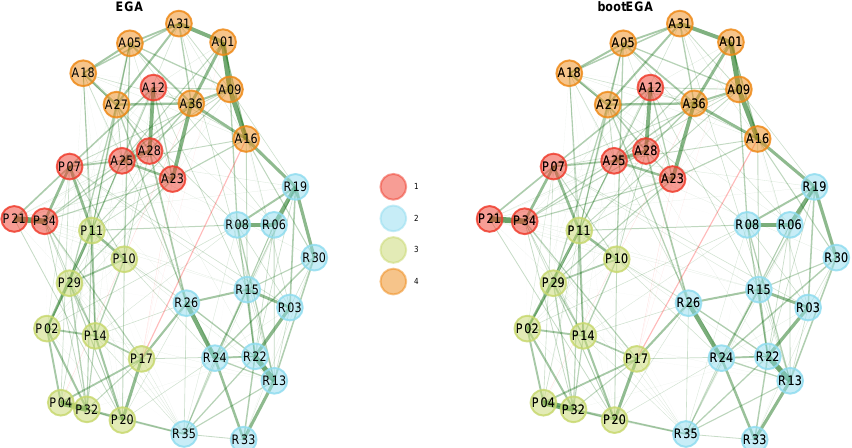
Figure 4. Dimensionality results for EGA ( left ) and bootEGA ( right ) for the Broad Autism Pheno- type